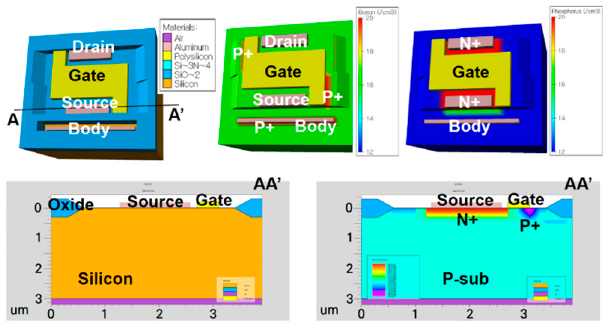
Figure 10. 3D characteristic model for the RH V-gate n-MOSFET and its cross-sectional view. Table 2. Geometry and doping profiles of the RH V-gate